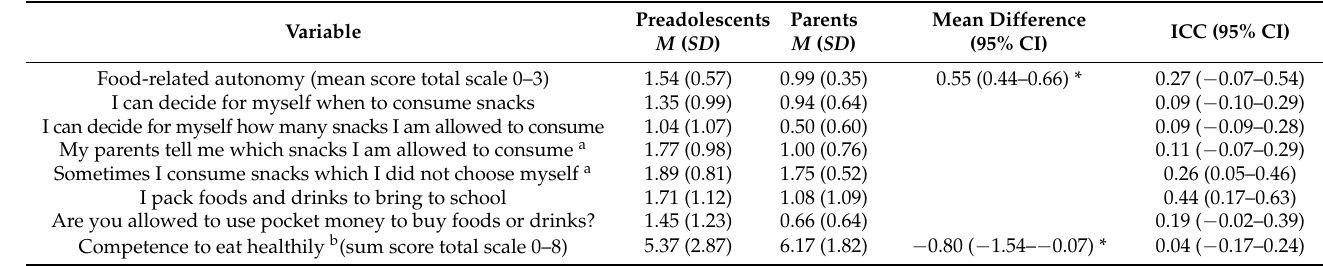
Table 4. Agreement between preadolescent and parent reports ( n = 81) on food-related autonomy and competence.